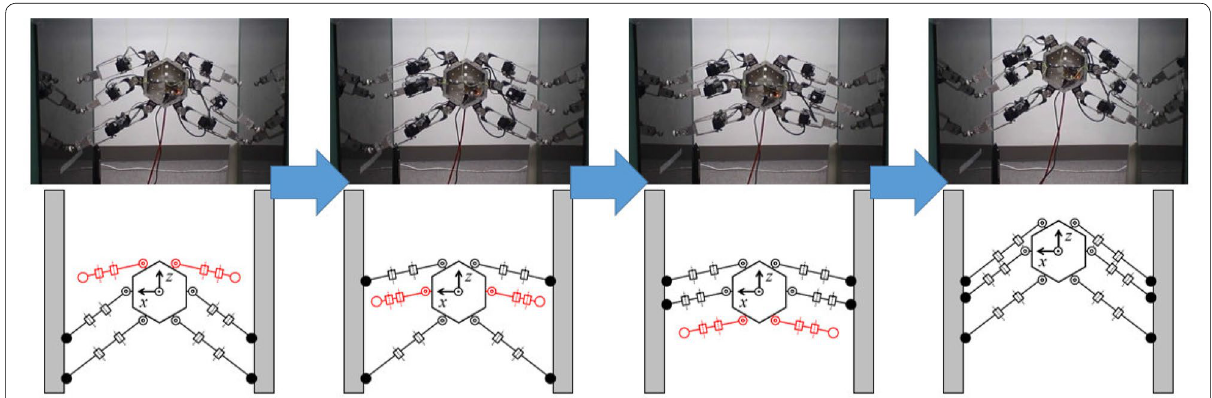
Fig. 6 Vertical-body climbing gait